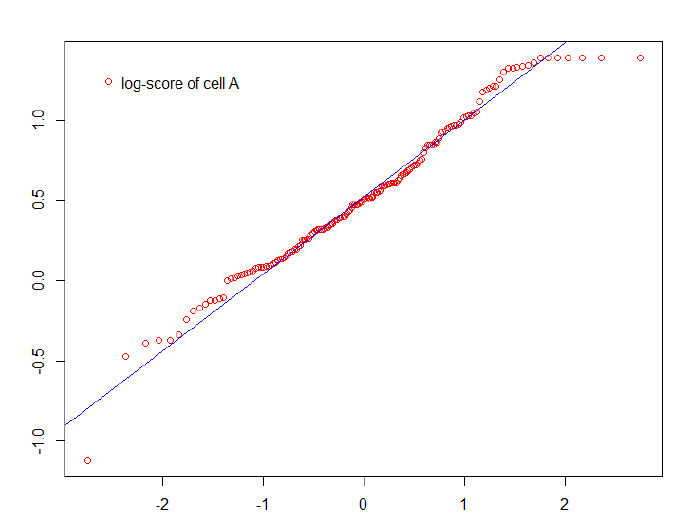
Figure 5. QQplot for cell B.